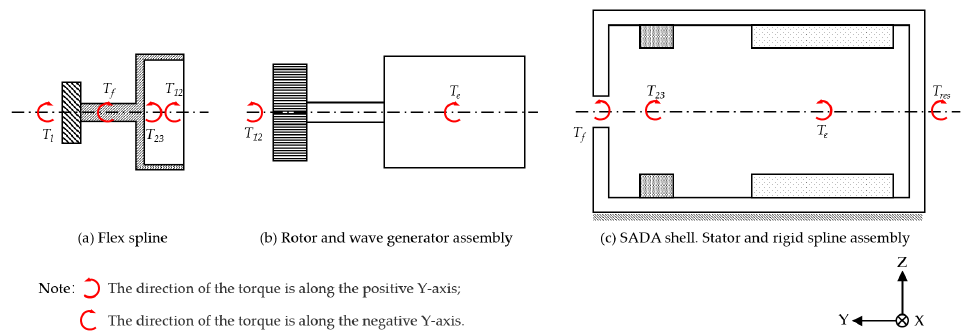
Figure 3. Force analysis of components.